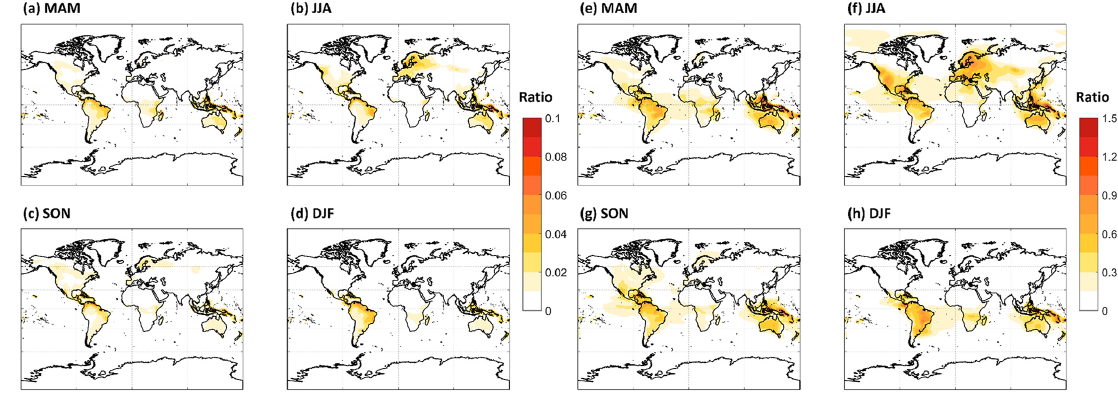
Figure 8. The seasonal PBL-averaged total C 10 HOM mass concentrations from the LowProd_Photo (a–d) or HighProd_noPhoto (e–h) simulations plotted relative to the total OA mass concentration predicted by GEOS-Chem for the same periods and locations. Note that the color scale for panels (a) – (d) (0 to 0.1) is about a factor of 10 lower than that for panels (e) – (h) (0 to